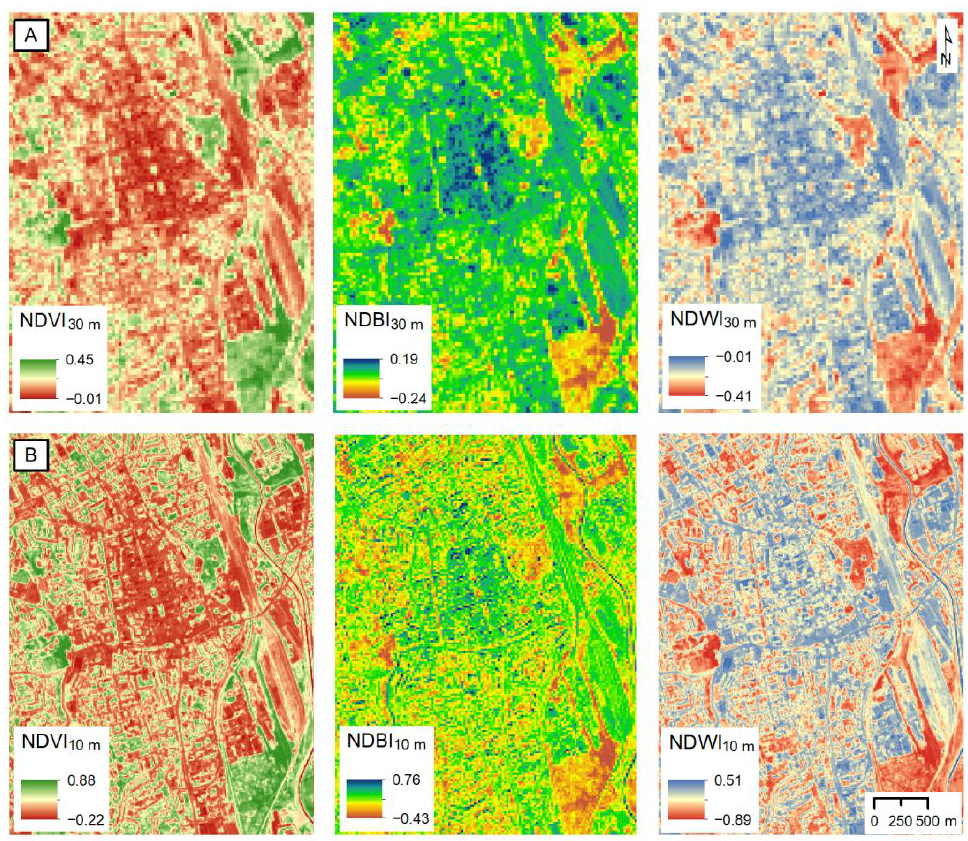
Figure 3. Spectral indices derived from ( A ) Landsat 8 OLI data in a spatial resolution of 30 m and ( B ) Sentinel-2 MSI data in a spatial resolution of 10 m (except for NDBI that was resampled from 20 m to 10 m).